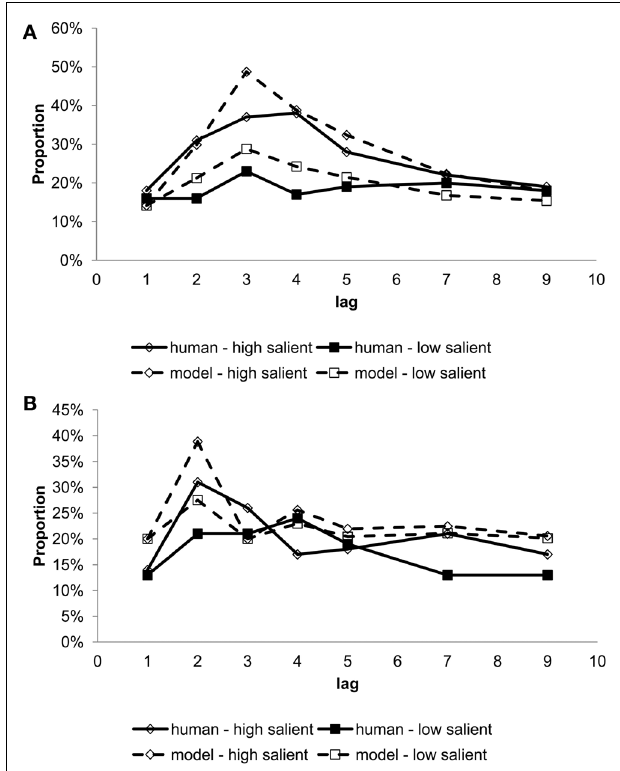
FIGURE 9 | Proportion of (A) “No” response and (B) “Yes” response (i.e., reflecting partial awareness) by serial position comparing human data (Barnard et al., 2004) and model simulation for high and low salient key-distractors.